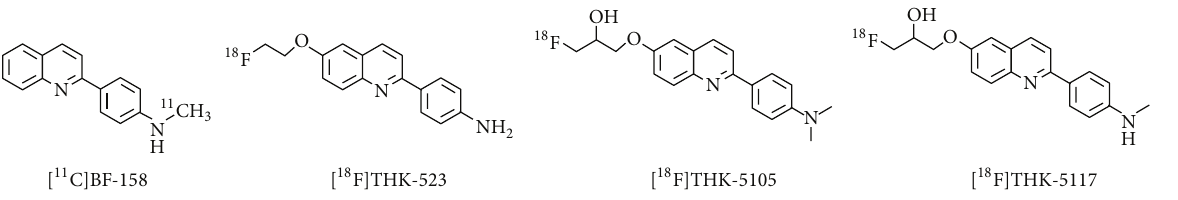
Figure 1: Chemical structures of quinoline derivatives for the imaging of tau [15–17].